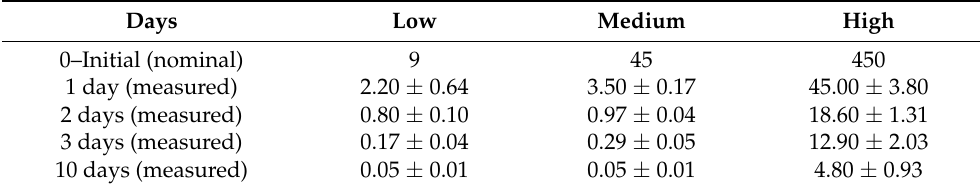
Table 1. Nominal and measured total hydrocarbon content (THC, mg/L) in treatment waters at exposure start (initial) and following 1, 2, 3, and 10 days of exposure to low, medium, and high crude oil treatments. Values are mean ± standard error ( n = 4).